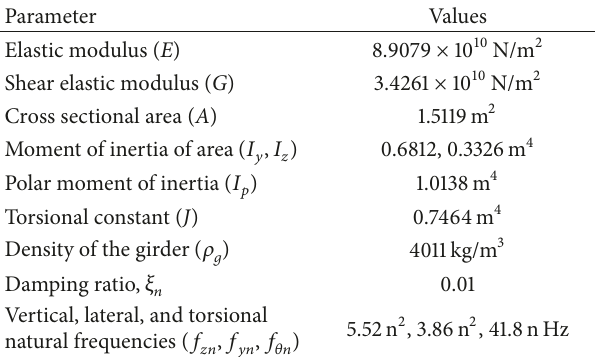
Table 6: Properties of the simply supported guideway girder